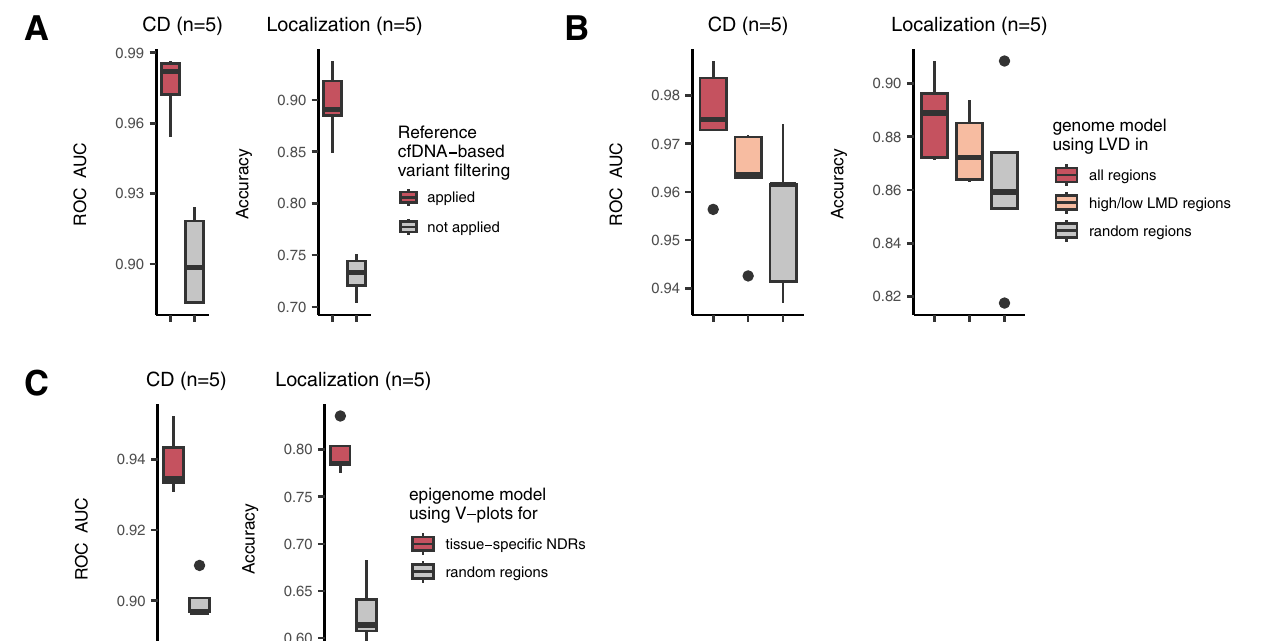
Fig. 4 | Contributions of the tumor and cfDNA reference data. A ROC-AUC and accuracy of the genome model depending on whether our reference cfDNA panel was used for cancer detection (left) and localization (right). B ROC-AUC and accuracyof the genome modelaccording to which genomicregions were used for LVD feature acquisition in cancer detection (left) and localization (right).The total numberofcancertype-speci fi chighorlowLMDregionsare264.Thesamenumber of random regions were selected for comparison with high or low LMD regions. C ROC-AUCandaccuracyoftheepigenomemodeldependingonwhichNDRswere